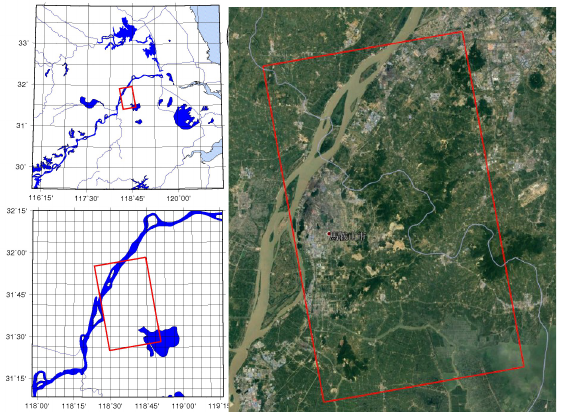
Figure 3 Landform features and footprint of TerraSAR- X/TanDEM-X images around Maanshan area